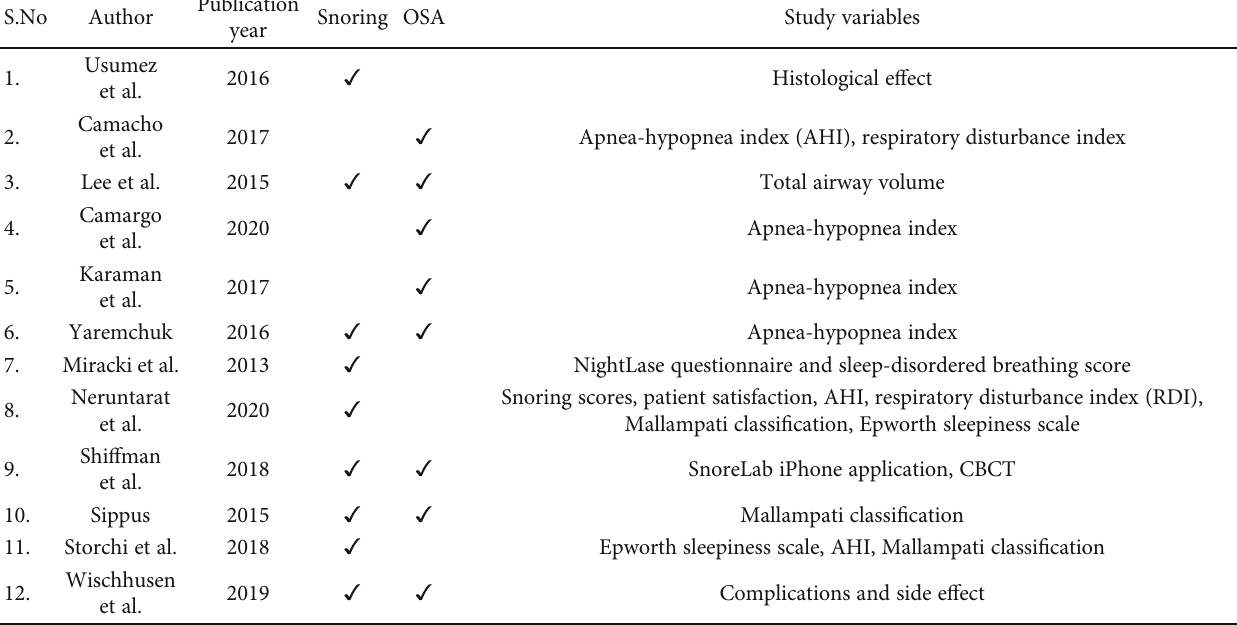
Table 4: Study based on OSA and snoring with their result measurement